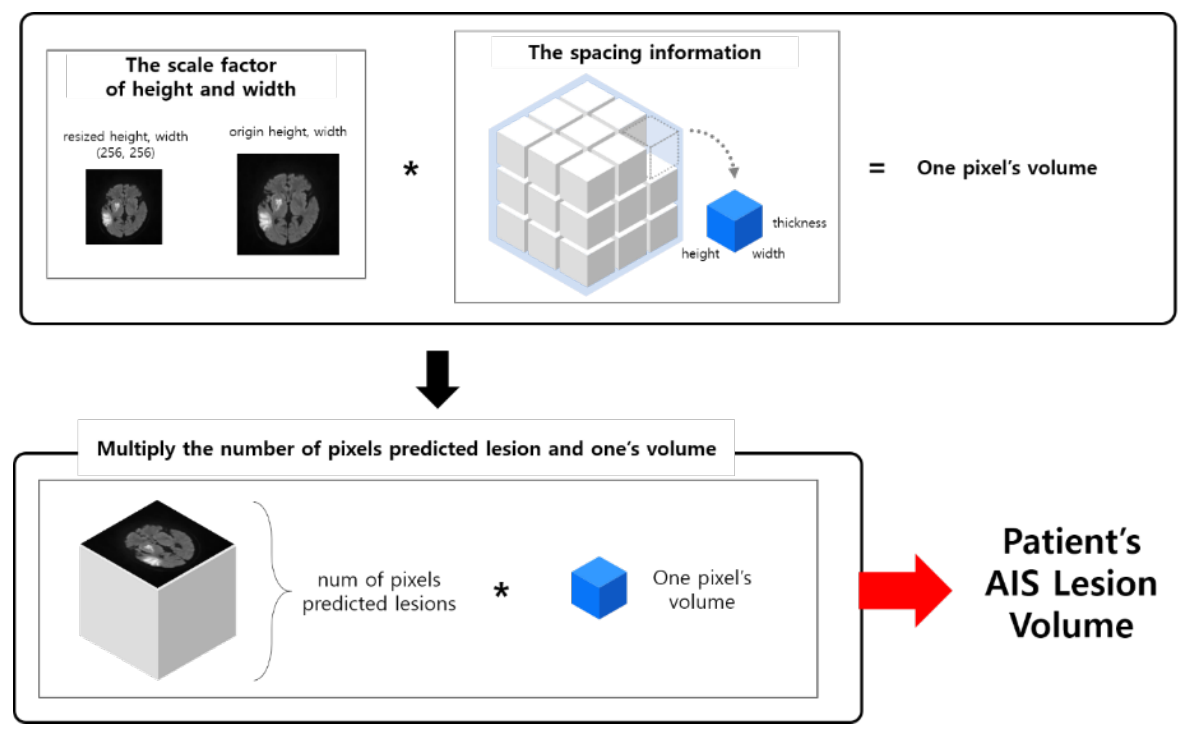
Figure 4. Flowchart of volume estimation .